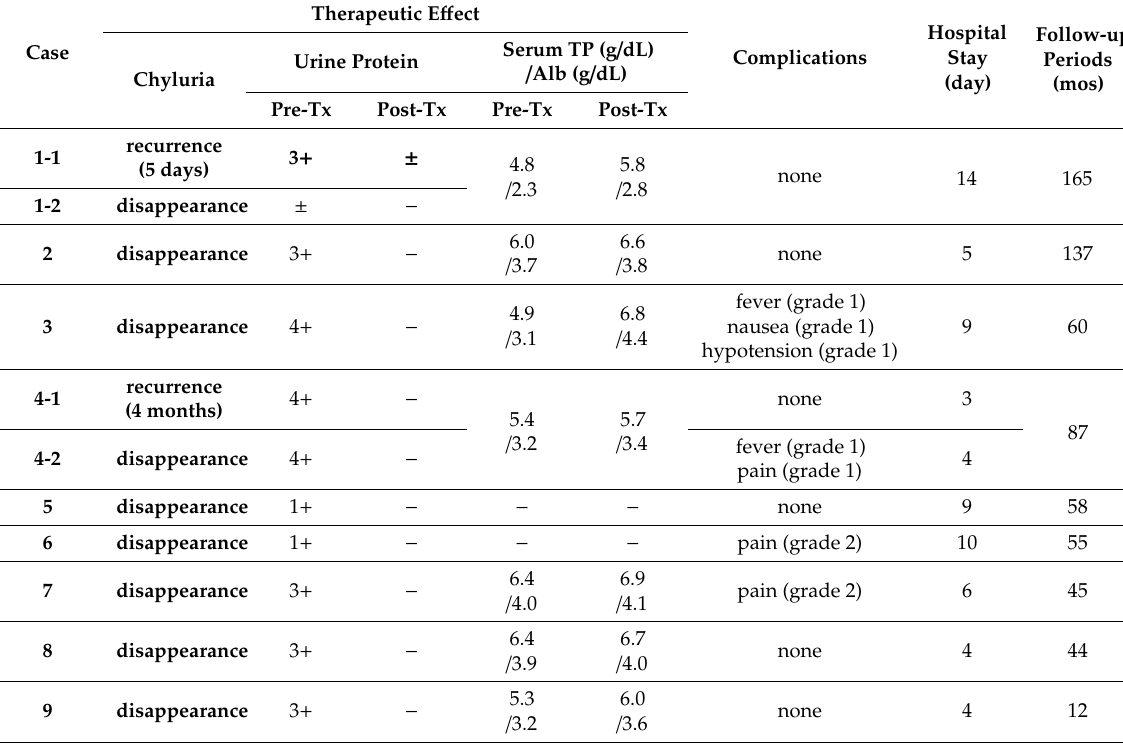
Table 2. Therapeutic e ff ect, complications, and duration of hospital